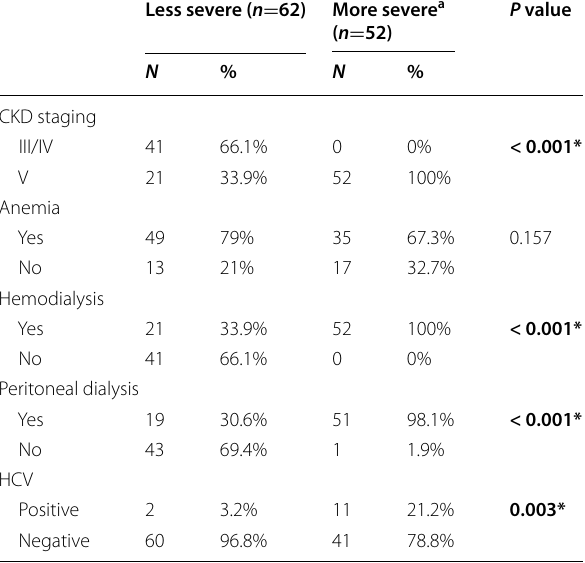
Table 4 Relation between fatigue severity and characteristics of patients with